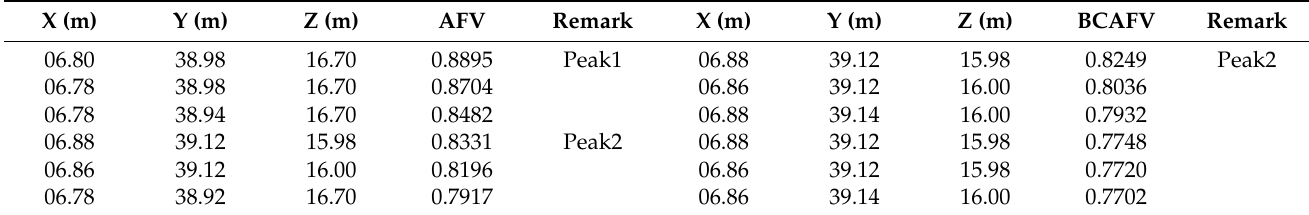
Table 4. Several large AFVs and BCAFVs and corresponding coordinates in epoch